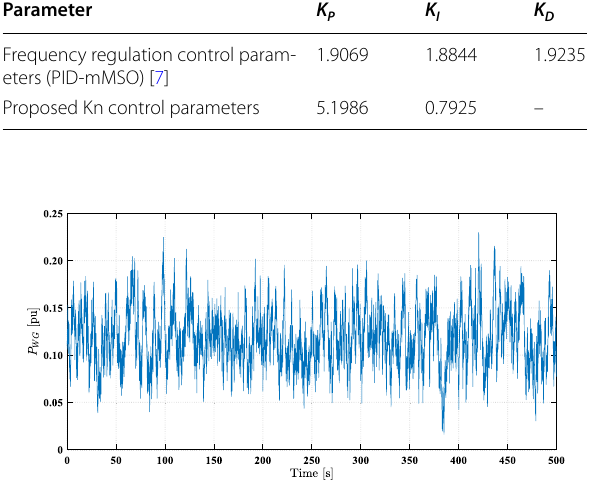
Table 4 Controller parameters for the HGS Parameter